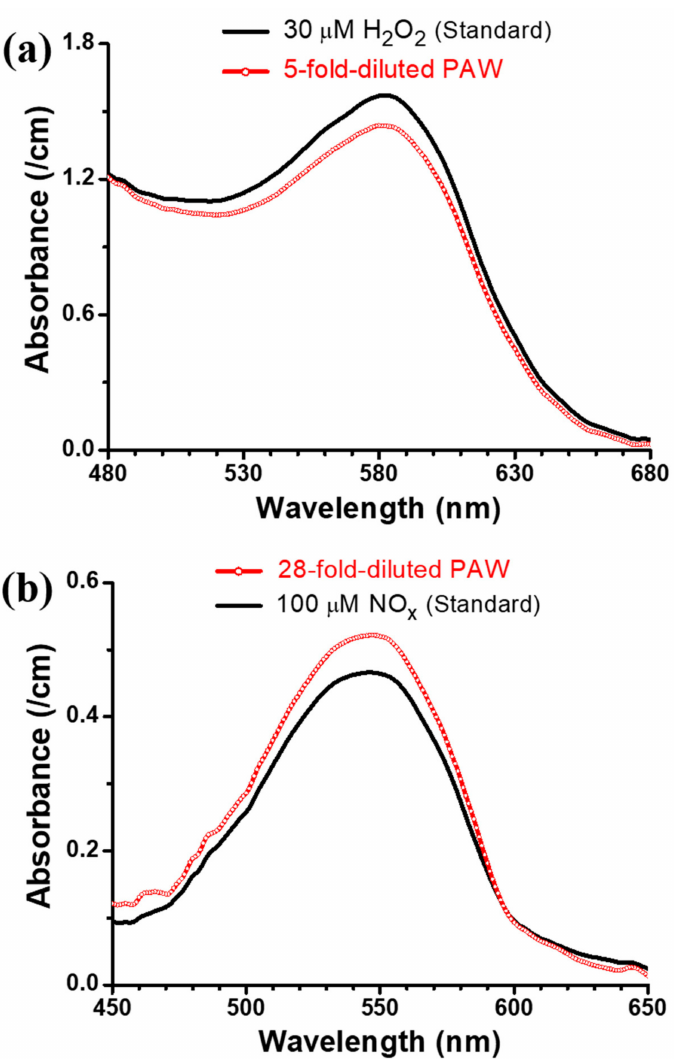
Figure 3. ( a ) Absorption spectra of 5-fold-diluted plasma-activated water and standard 30 µ M H 2 O 2 solutions mixed with a QuantiChromTM Peroxide Assay Kit ( DIOX -250). ( b ) Absorption spectra of 28-fold-diluted plasma-activated water and standard 100 µ M NO x solutions mixed with a QuantiChromTM Nitric Oxide Assay Kit ( D 2 NO -100). The plasma-activated water was obtained